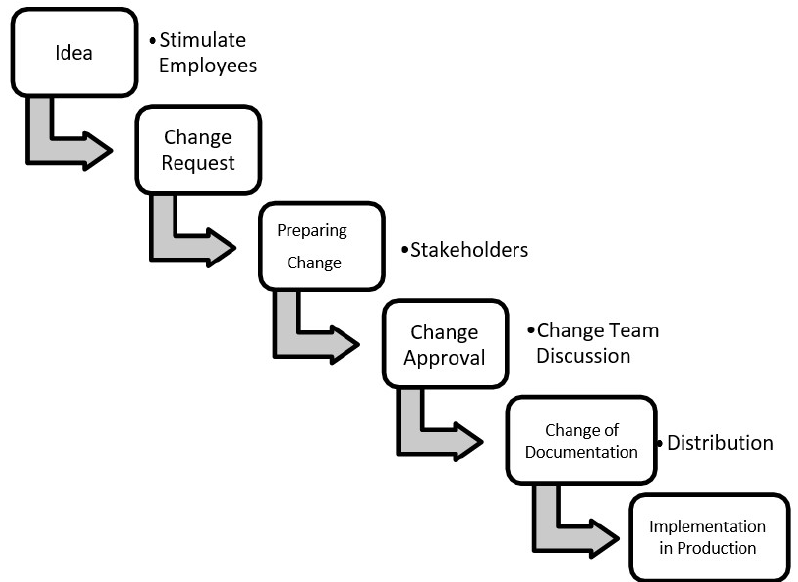
Figure 1. General Change Process Scheme (Adapted from Tavcar and Duhovnik [15]).